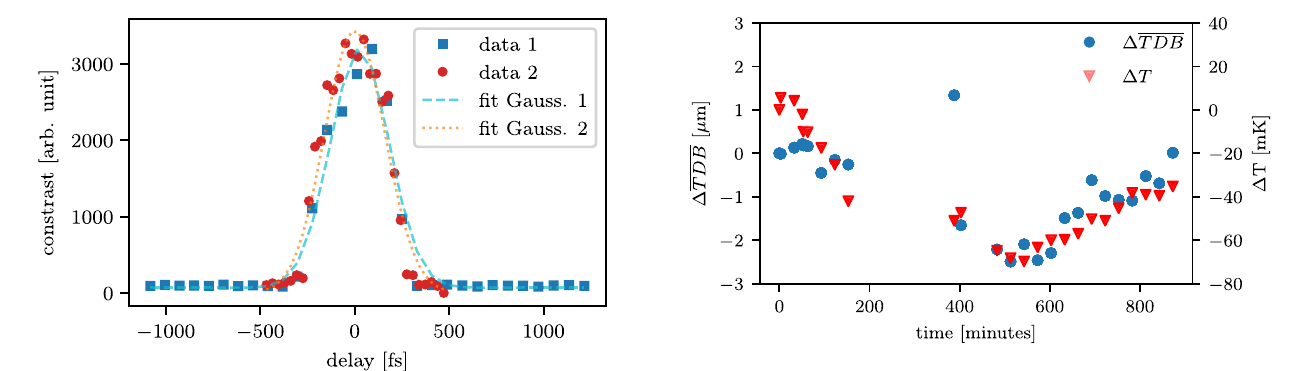
FIG. 33. Example of an automated synchronization scan ob- tained for the MPS3 at to different moments of a day during the commissioning.